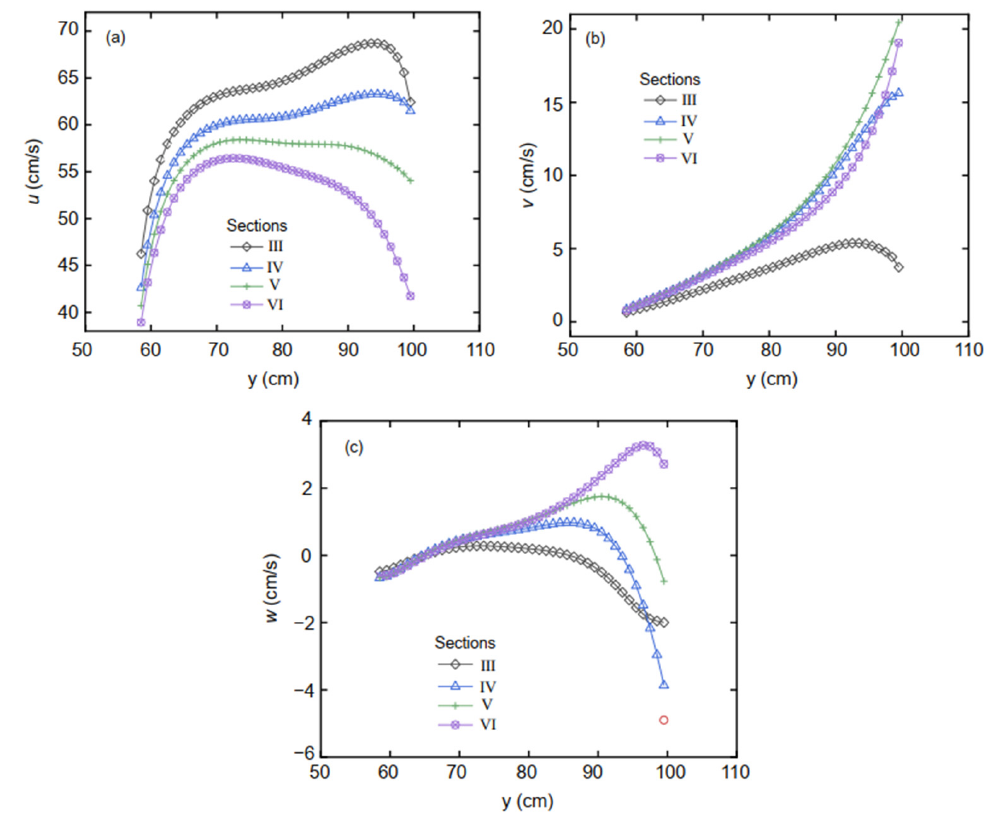
Figure 8. Velocity distribution at different sections. Note: Water depth of 1.5 P ; Q 1 = 40 L/s; b = 30 cm. ( a ) The x-direction with velocity u ; ( b ) the y-direction with velocity v ; and ( c ) the z-direction with velocity w .